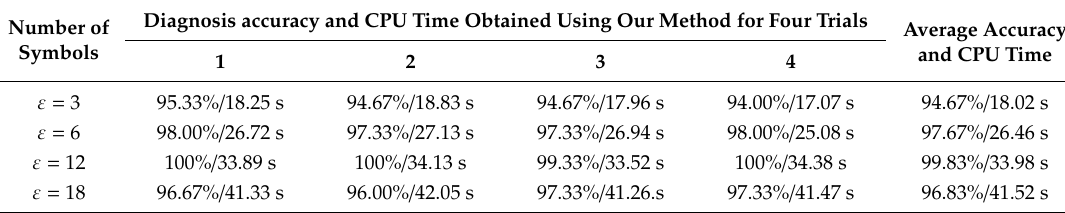
Table 5. Identification results of the proposed method in four